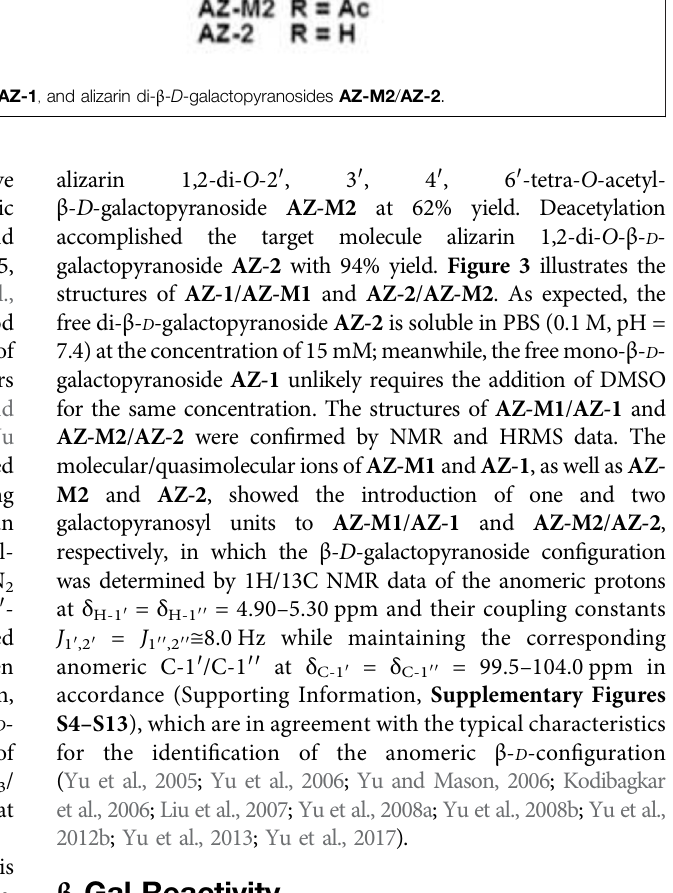
Frontiers in Chemistry |